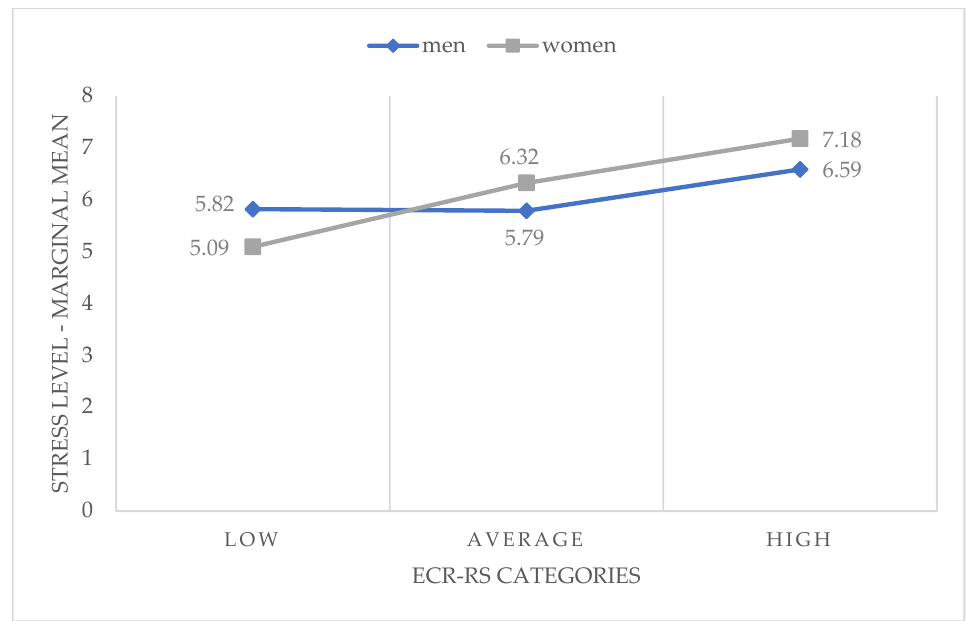
Figure 2. Interaction between gender and the assessment of relationship attachment styles (ECR-RS categories) as predictors of perceived stress level in women and men (N = 1405) (marginal means from the GLM model).